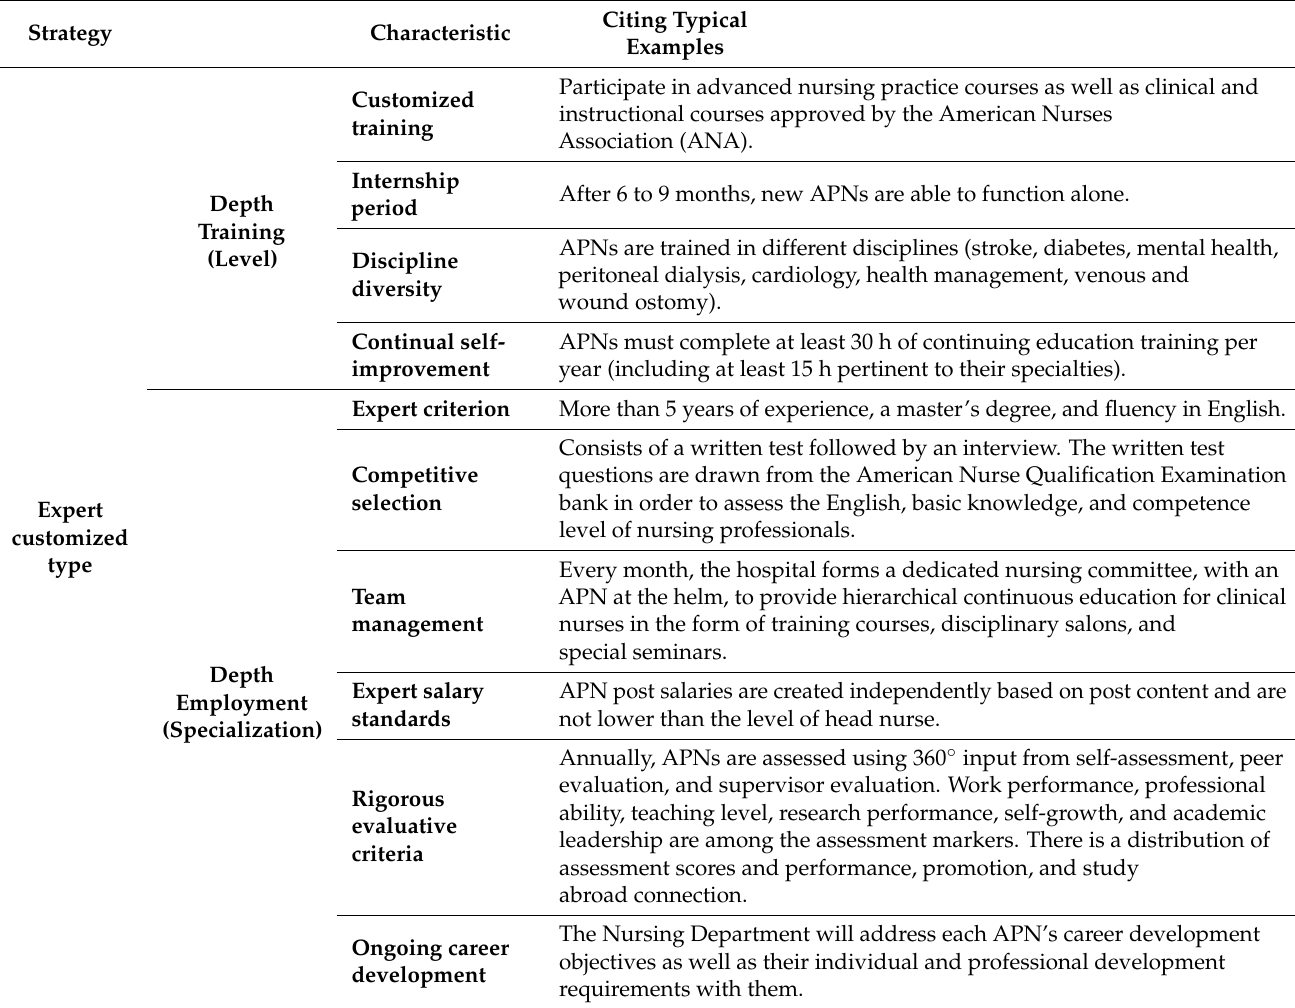
Table 4. Typical examples of management strategies of expert customized